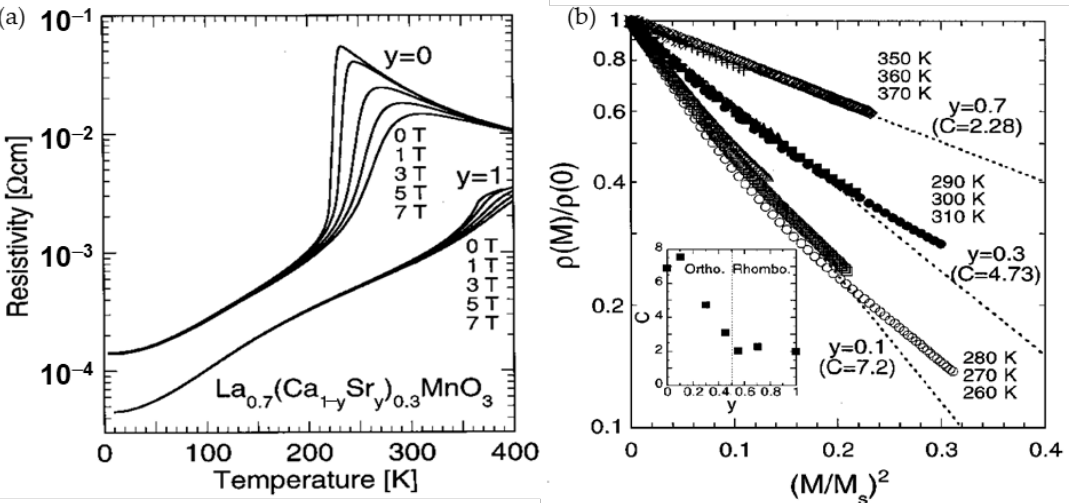
Figure 4. ( a ) Resistivity vs. temperature dependences for La 0.7 (Ca 1-y Sr y ) 0.3 MnO 3 crystals with different chemical compositions. The observed MR at y = 0 is much stronger in comparison to y = 1; and ( b ) normalized resistivity represented on logarithmic scale as a function of the square of reduced magnetization for y = 0.1, 0.3, and 0.7. The inset shows the variation of a slope of this plot (constant C) with change of y . Reprinted with permission from [42], © 1995 American Physical Society.